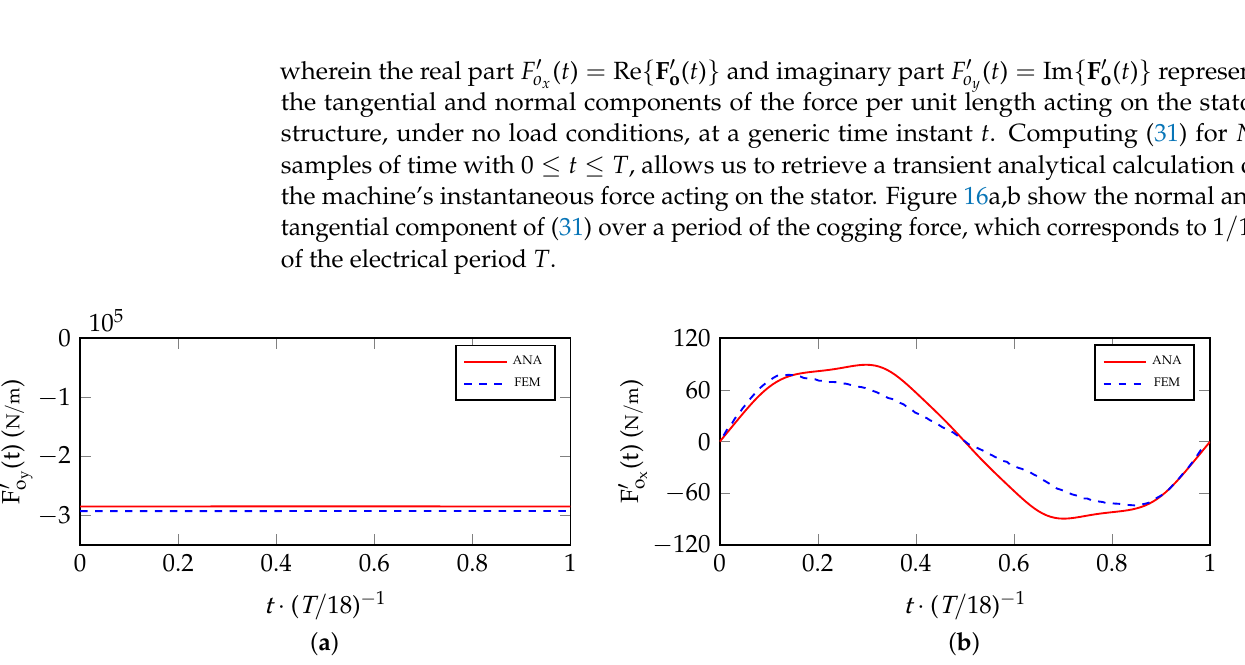
Figure 16. Analytical and FEM no load force per unit length of the slotted machine of Figure 5a (0 t T / 18 N t = 120). ( a ) normal component; ( b ) tangential component. The analytical calculation ≤ ≤ was based on (31) and FEM curve was calculated using the Maxwell tensor.